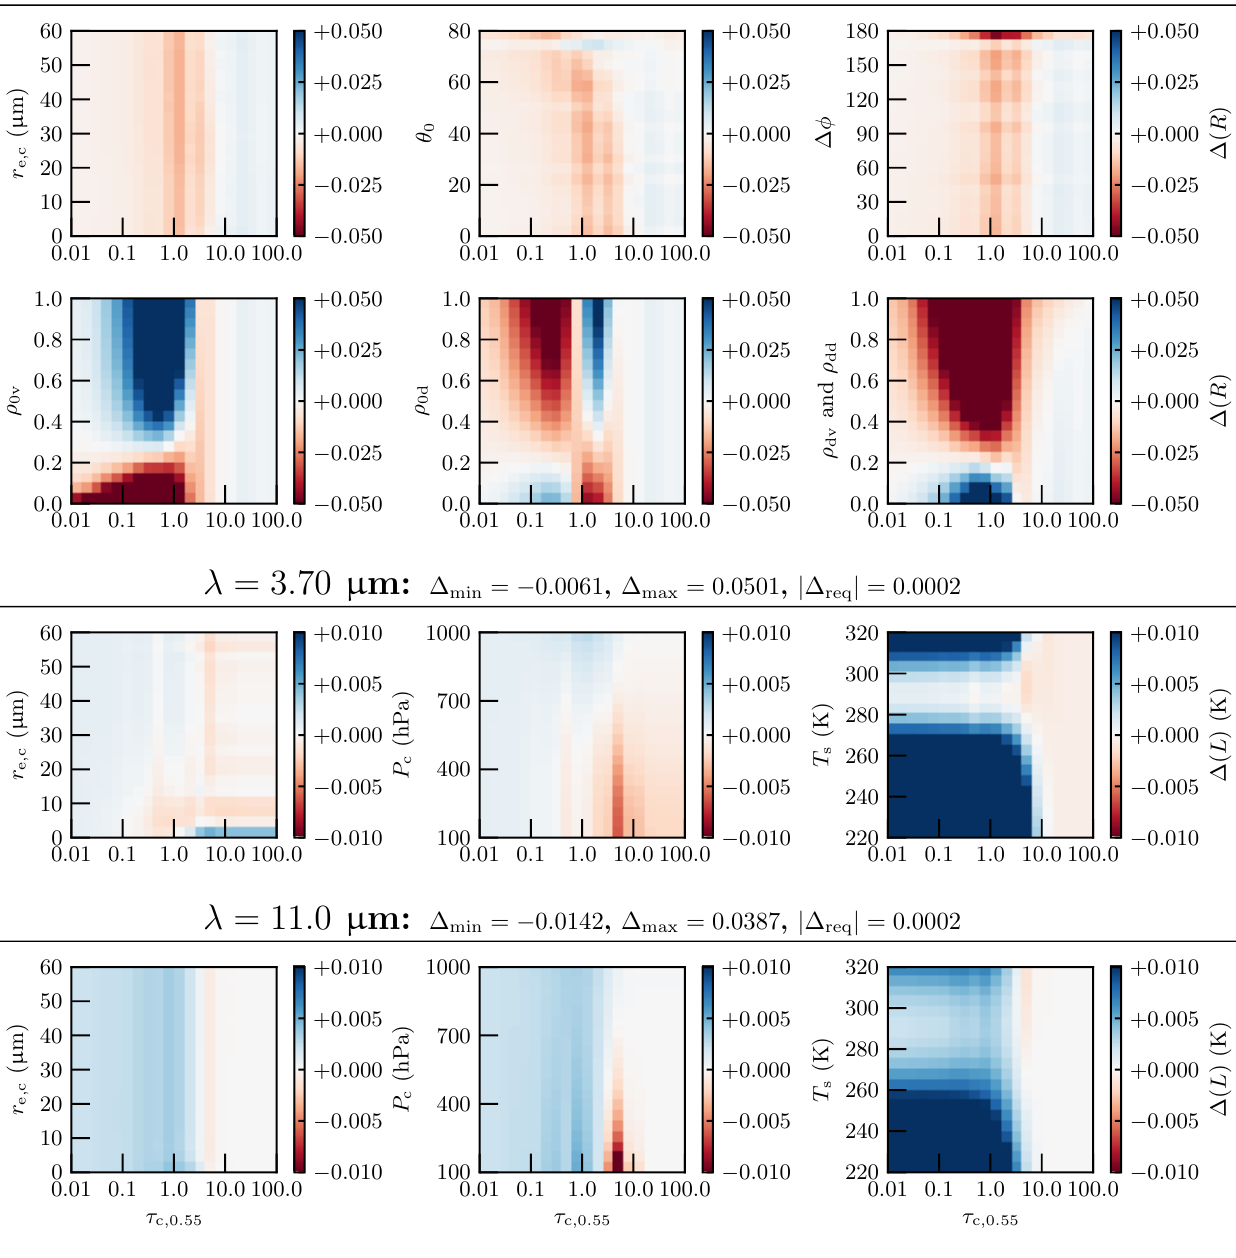
Figure 4. Same as Fig. 3 but for ice